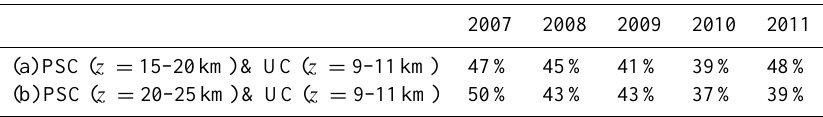
Table 2. (a) Percentage of simultaneously occurring PSCs at 15–20km and UCs at 9–11km that are in the presence of blocking highs. (b) The same as (a) but for PSCs at 20–25km and UCs at 9–11km.